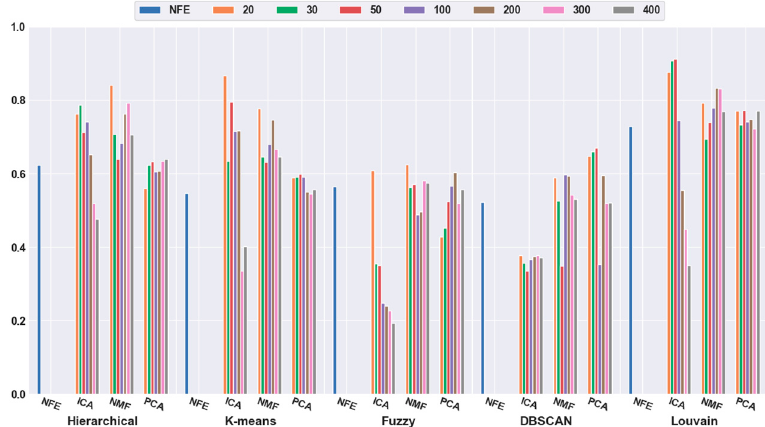
Figure 3. Comparison results of the five clustering methods with feature extraction on the mouse cortex data with 500 genes. From left to right, the blue, orange, green, red, brown, violet, khaki, pink, and gray bars indicate the results of five clustering models in the original feature space, 20 dimensional, 30 dimensional, 50 dimensional, 100 dimensional, 200 dimensional, 300 dimensional, and 400 dimensional feature spaces, respectively. ICA and PCA represent independent component analysis and principal component analysis algorithm.